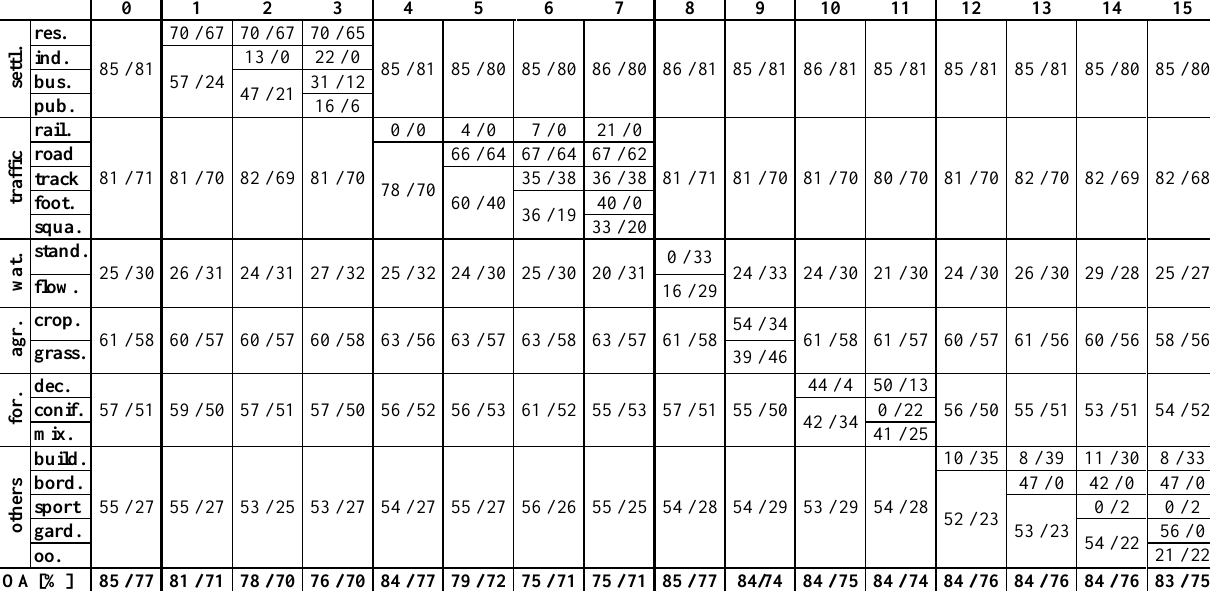
Table 2. Quality measures [%] and overall accuracy (last row; OA) [%] for the land use classes defined in Table 1 obtained by applying our classification approach to hierarchically refined class structures for the test areas Hameln (first entry in each field) and Schleswig (second entry). The first row contains an index for the experiment. In experiments 1-3, more and more subcategories for the main category settlement were successively distinguished, experiments 4-7 are dedicated to the refinement of traffic ,